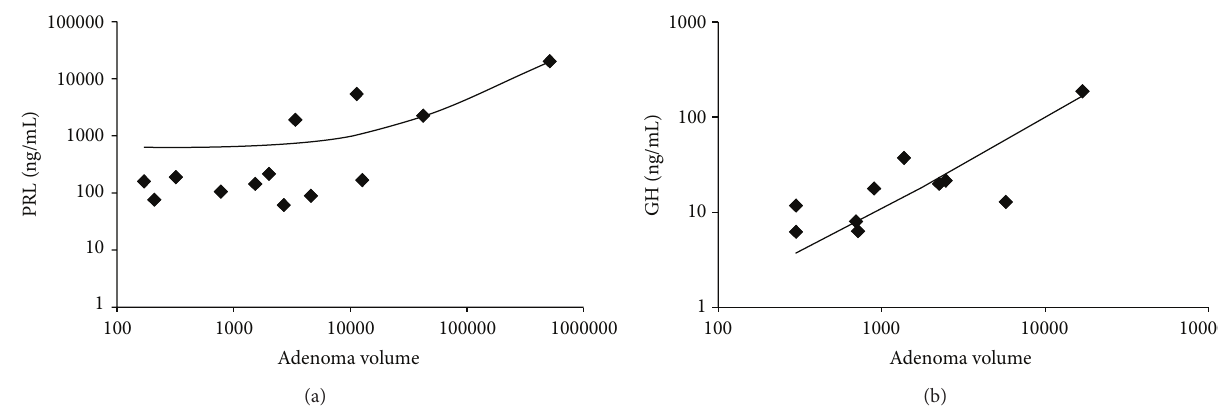
Figure 6: Correlation between adenoma volume and hormone value. (a) Prolactin-secreting adenomas. (b) GH-secreting